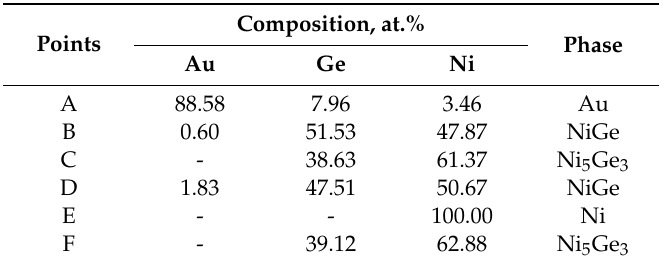
Figure 10. The fracture surfaces of solder joints: ( a ) as soldered; ( b ) elemental mapping of ( a ); ( c ) after 100 cycles; ( d ) elemental mapping of ( c ); ( e ) after 200 cycles; ( f ) elemental mapping of ( e ); ( g ) after 300 cycles; ( h ) elemental mapping of ( g ); ( i ) after 400 cycles; ( j ) elemental mapping of ( i ). Table 4. The EDS results of Figure 10.